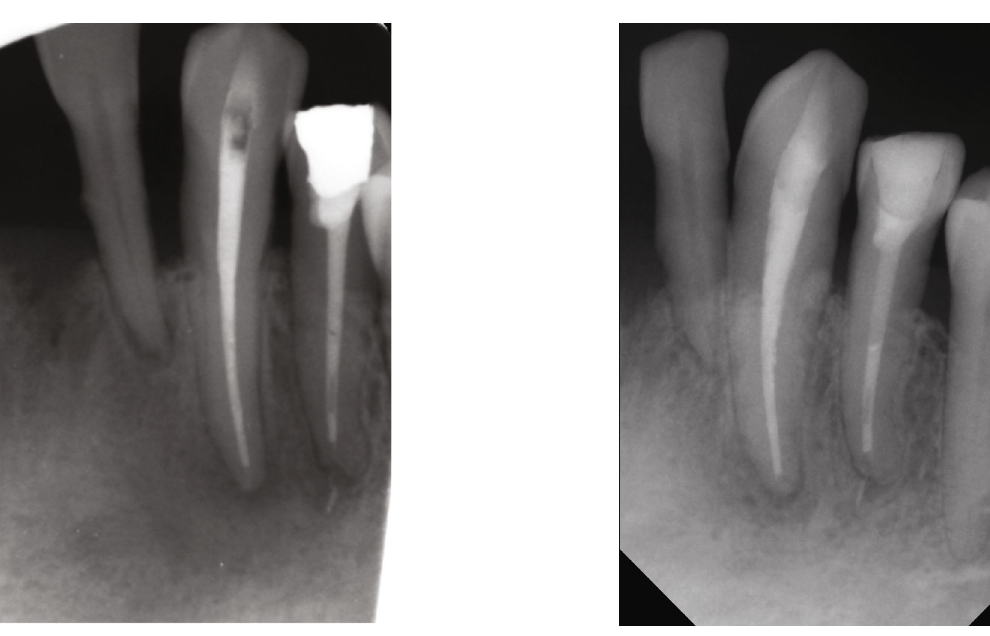
Figure 7: 1-year recall periapical radiograph showing healing of the